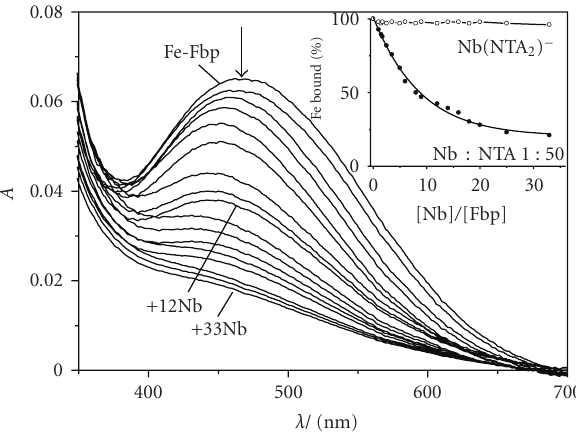
Figure 4: Displacement of Fe III from holoFbp (25 μ M) by 1:50 Nb:NTA under the same conditions as Figure 2(a). Molar ratio of Nb/Fbp (from top to bottom) is 0, 2, 4, 6, 8, 10, 15, 20, 25, 30, and 33. insert shows the percentage of Fe III bound to the protein calculated from the LMCT band at 465nm. Little Fe III is displaced ] − (open circles) whereas 1: 50 Nb:NTA gives rise to by [Nb(NTA) 2 almost complete displacement of Fe III from holoFbp (filled circles).